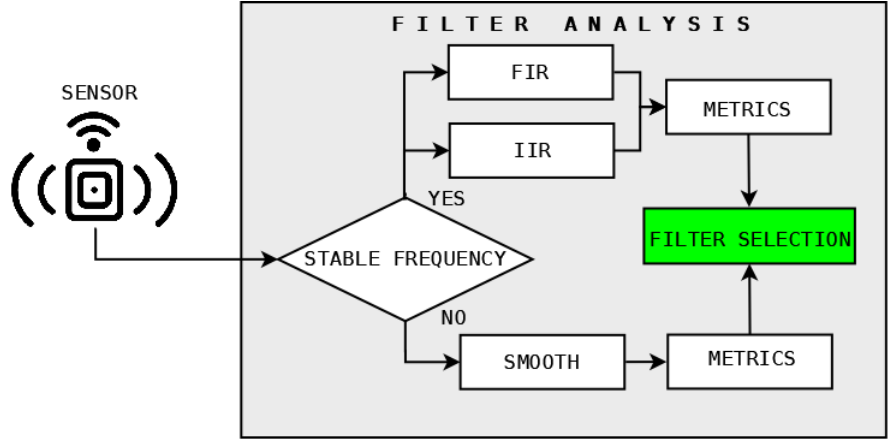
Figure 2. Sensor data and pre-preprocessing